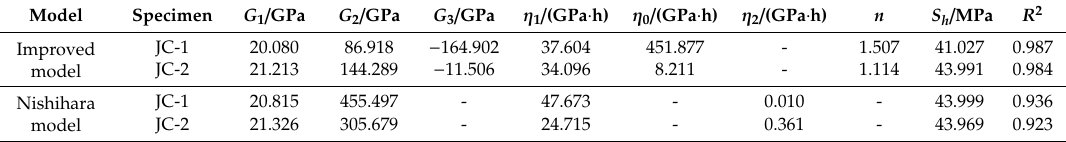
Table 4. Parameter fitting results of di ff erent creep models.